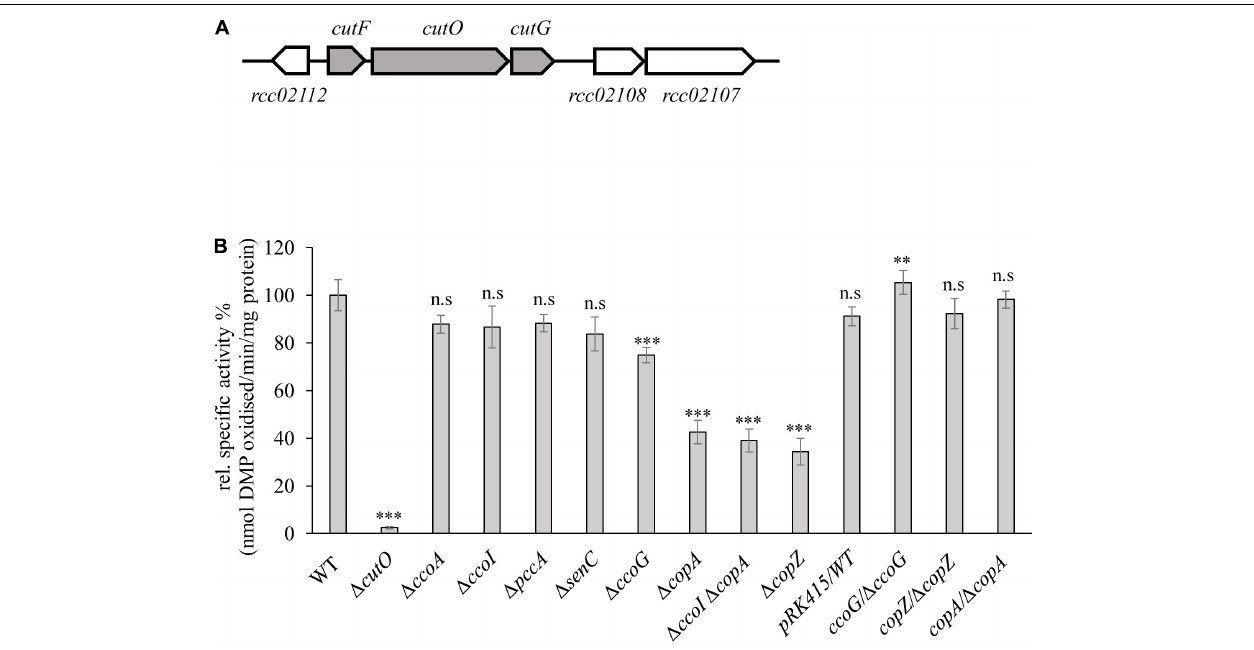
FIGURE 1 | Genetic organization and activity of the multi-copper oxidase (MCOs) CutO in Rhodobacter capsulatus . (A) Genetic organization of the cutFOG operon in R. capsulatus . CutO codes for the multicopper oxidase ( rcc02110 ), and cutF ( rcc02111 ) and cutG ( rcc02109 ) for largely uncharacterized proteins. The open reading frame rcc02112 encodes a putative glyoxalase/bleomycin resistance protein/dioxygenase. The open reading frames rcc02108 and rcc02107 encode hypothetical proteins with unknown function. (B) CutO activity of different R. capsulatus mutants deficient in cbb 3 -Cox assembly and Cu homeostasis. Periplasmic fractions were isolated from the indicated strains, grown in magnesium–calcium, peptone, yeast extract (MPYE) medium supplemented with 10 µ M CuSO 4 . 50 µ g periplasmic soluble protein was used in the 2,6-DMP assay and absorbance was measured at 468 nm. The activity of wild-type (WT) was set to 100% and the relative activities of the indicated strains were calculated. The activities of mutant strains that showed significantly reduced CutO activity were also tested after complementation with pRK415-borne copies of the respective genes. WT containing the pRK415 vector served as a control. Three independent experiments were performed with three technical replicates and the error bars reflect the standard deviation ( n = 9). Statistical analyses were performed with the Satterthwaite corrected two-sided Student t -test, using the activity of the WT as reference. ( ∗ ) refers to p -values ≤ 0.05; ( ∗∗ ) to p -values ≤ 0.01, and ( ∗∗∗ ) to p -values ≤